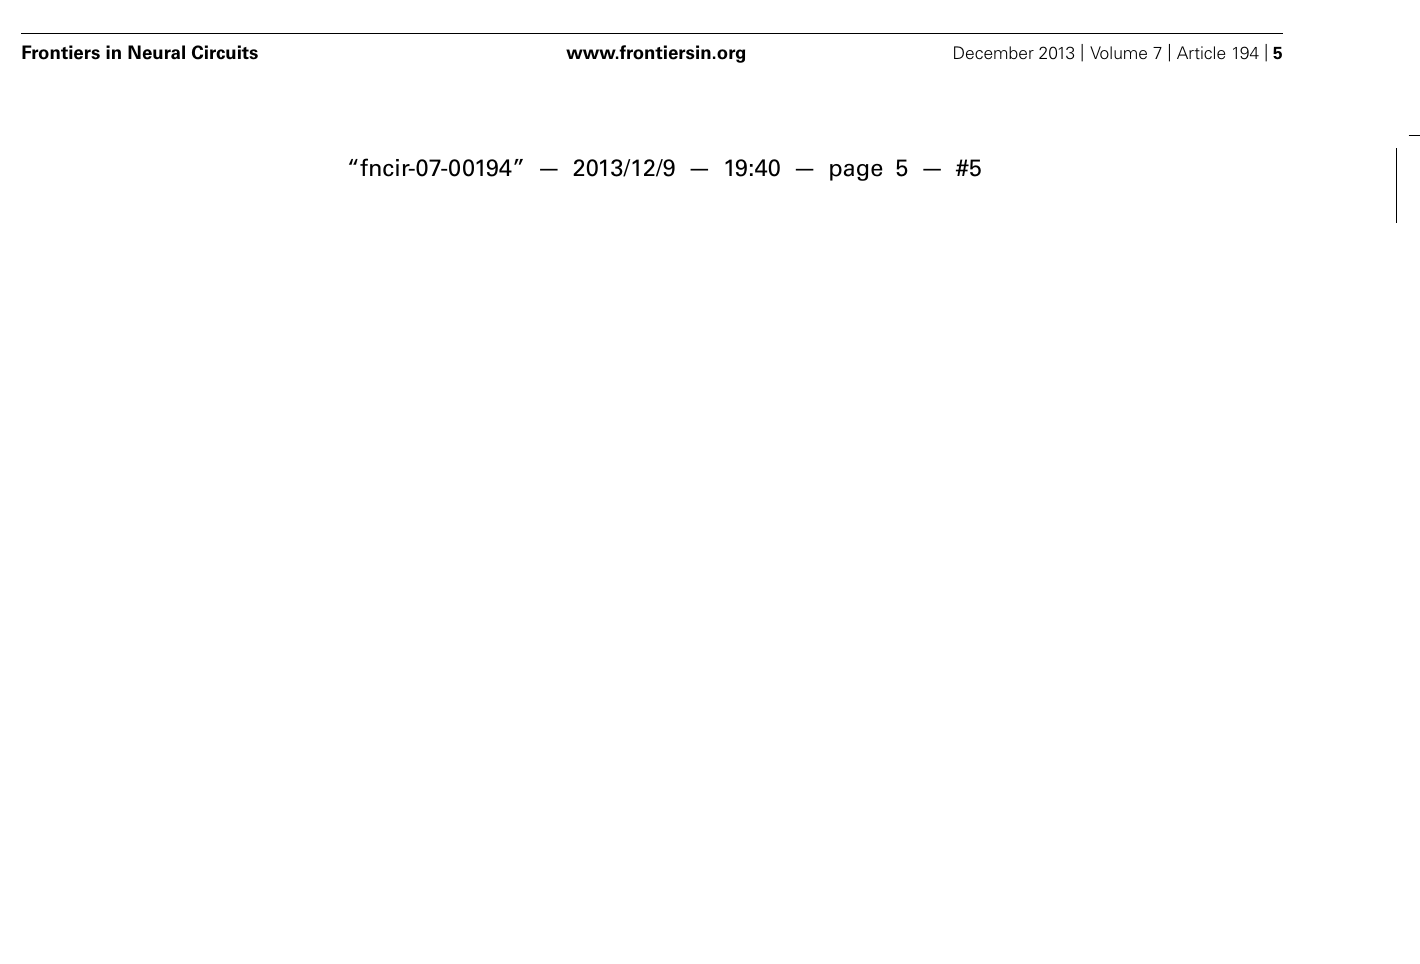
equal to the delay.This is not generic for antiphase, but rather a special case as explained in the text. (D) For longer delays, again only one time lag is equal to the delay, this time the longer time lag (see asterisk). (E) For delays almost equal to an intrinsic period, the trajectories do not converge to synchrony, instead the neurons switch their firing order on each cycle.The delays are equal to the time lags (asterisks). Parameters for the coupled LIF are γ = 0.9, S 0 = 1, ε =